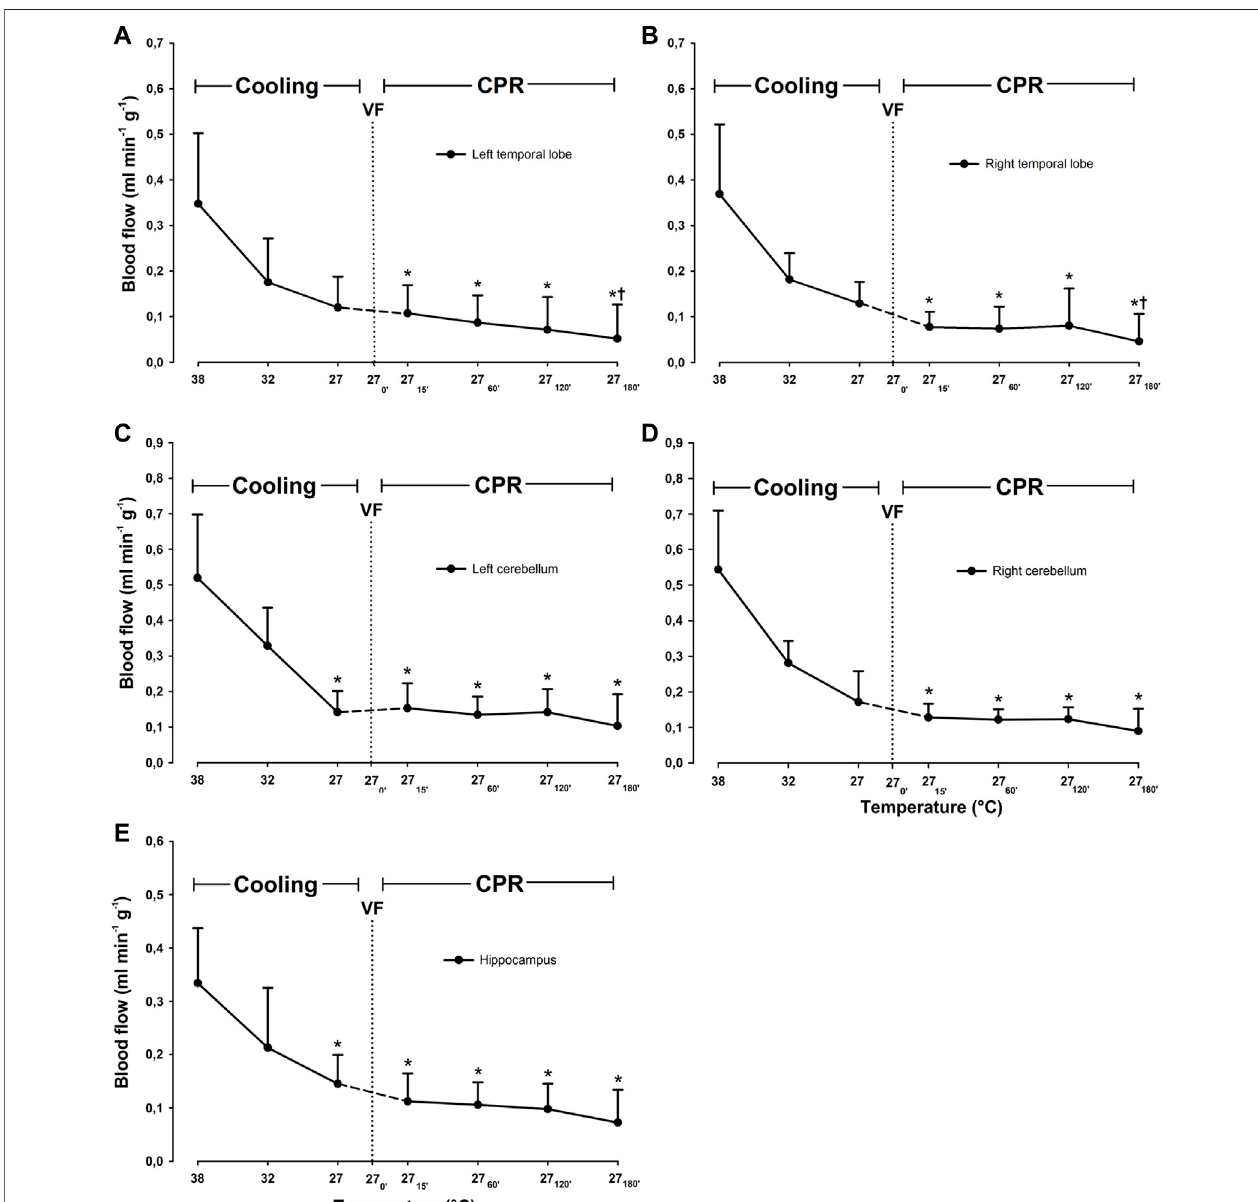
FIGURE3 | Cerebral blood fl owduring cooling and 3 h CPR at 27 ° C. (A) left temporal lobe blood fl ow, (B) right temporal lobe blood fl ow, (C) left cerebellum blood fl ow, (D) right cerebellum blood fl ow, (E) hippocampus blood fl ow. Values are mean ± SD ( n = 8). * p < 0.05 vs. intragroup 38 ° C baseline; † p < 0.05 vs. intragroup spontaneous circulation at 27 °